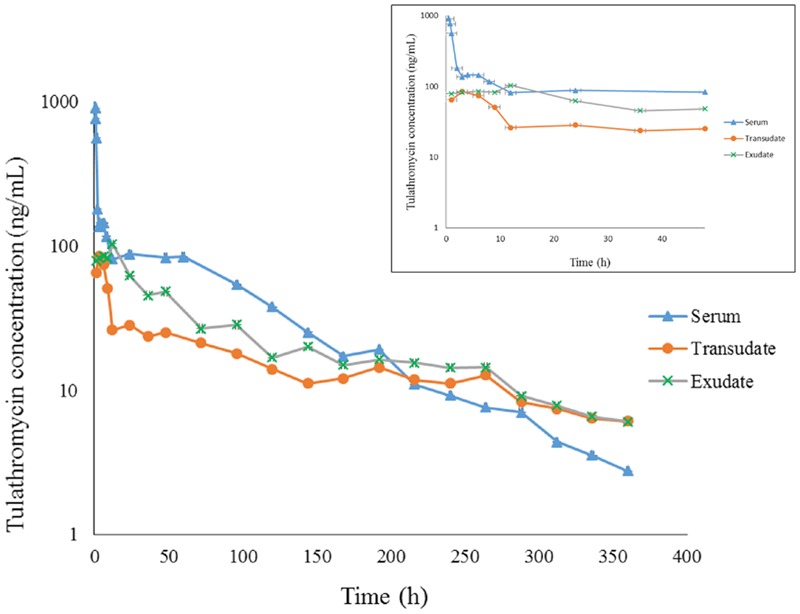
The concentration-time curve for tulathromycin in serum, transudate and exudate after i.v. administration at a dosage of 2.5 mg/kg body weight (for clarity the small graph depicts the drug concentrations in the first 48 h post-administration).